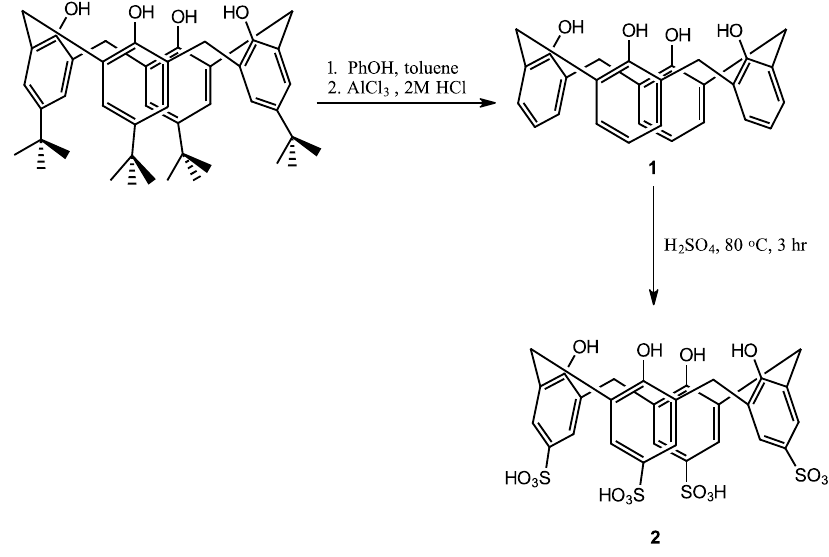
Figure 1. Reaction scheme of p ‐ sulfonatocalix[4]arene synthesis .